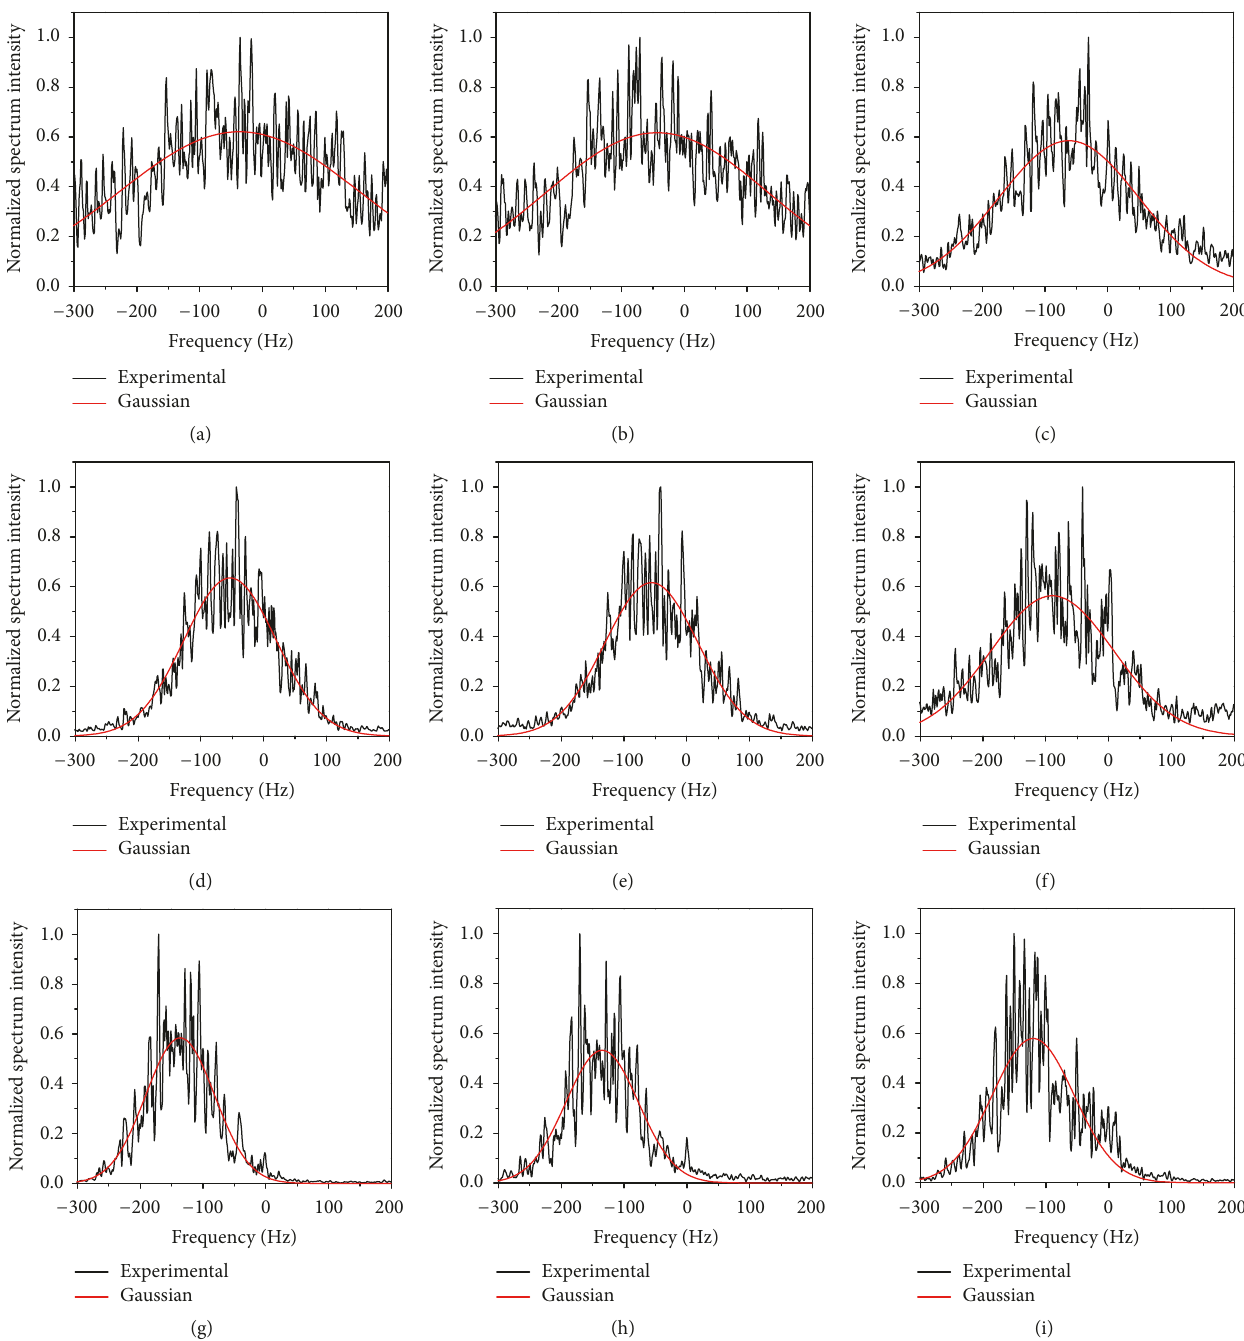
Figure 22: Examples of individual spectra for the different range and time bursts: ((a)–(c)) sum channel and elevation and azimuth difference channels for the 178th range cell within the first time burst. ((d)–(f)) Sum channel and elevation and azimuth difference channels for the 286th range cell within the first time burst. ((g)–(i)) Sum channel and elevation and azimuth difference channels for the 286th range cell within the 45th time